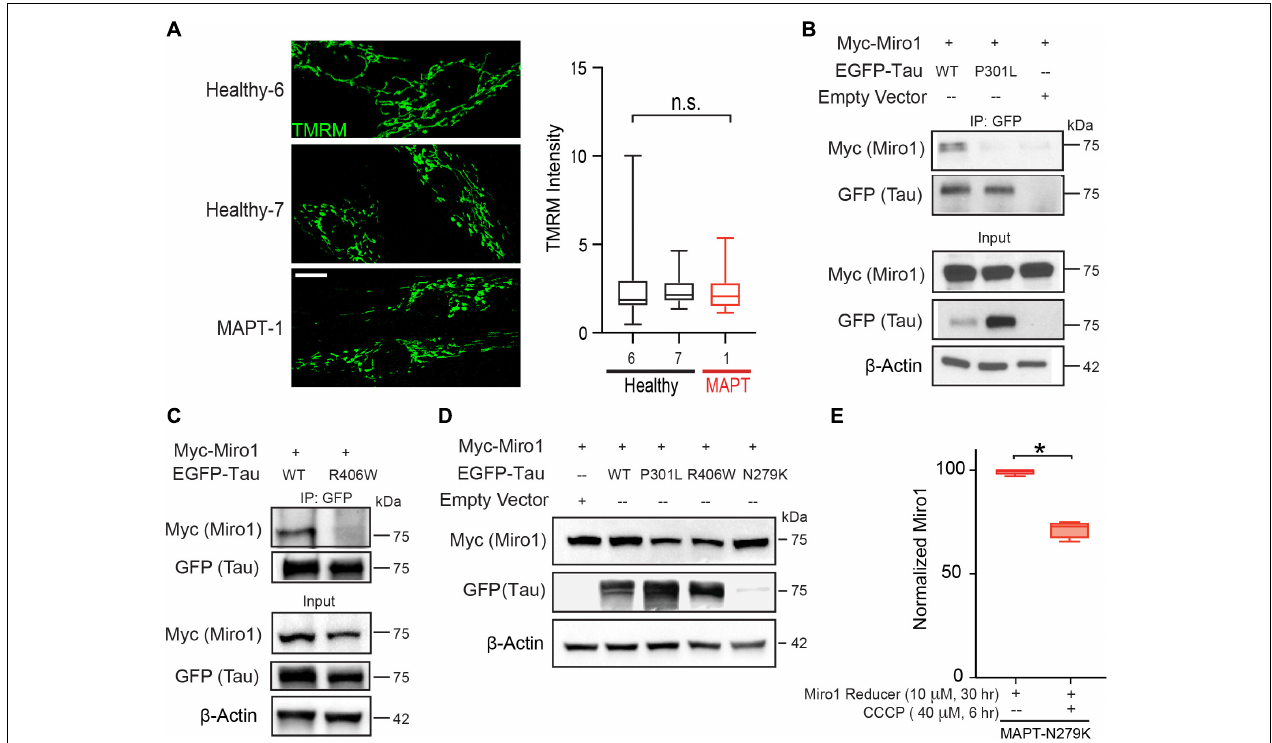
FIGURE 4 | The mitochondrial network in fibroblasts, tau interaction with Miro1, and effect of Miro1 Reducer. (A) Confocal images show mitochondria stained with TMRM in fibroblasts. The mean TMRM intensity of each cell is normalized to the background intensity and quantified. N = 43 (Healthy-6), 46 (Healthy-7), and 42 (MAPT-1) cells from 4 to 5 images per coverslip from 3 coverslips. One-Way ANOVA Post Hoc Tukey Test. Scale bar: 10 µ M. (B,C) Co-IP with anti-GFP from HEK cells transfected as indicated. (D) HEK cells transfected with different tau and Miro1 constructs were lysed and blotted. (E) ELISA of Miro1 protein in MAPT-1 fibroblasts treated as indicated, N = 4. Mann-Whitney U Test. * P < 0.05. n.s.: not